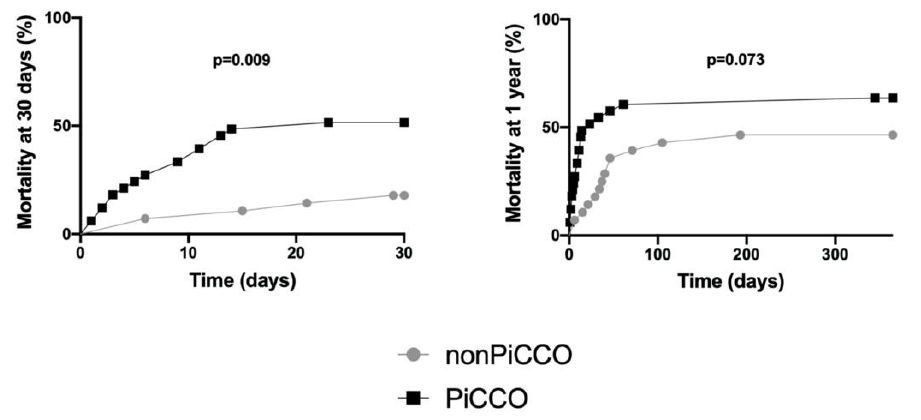
Figure 3. Cumulative incidence of 30 day and 1 year mortality by PiCCO status. Kaplan–Meier curves and log-rank tests were performed. p : level of significance; and PiCCO: pulse index contour cardiac output.